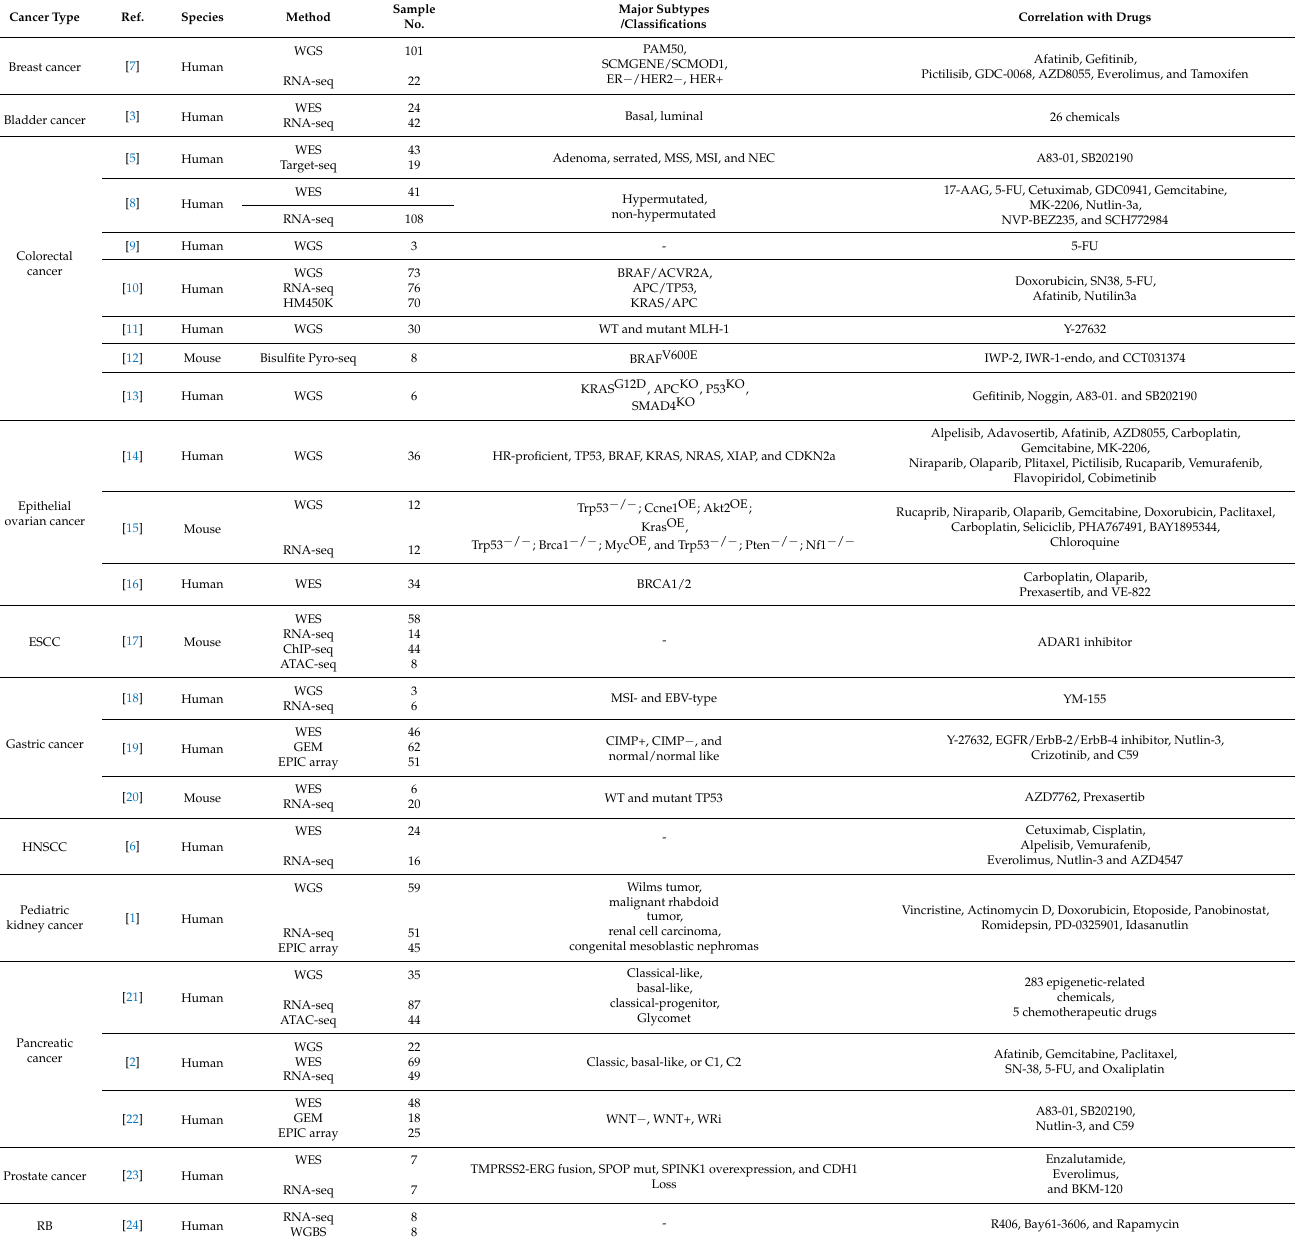
ESCC, esophageal squamous cell carcinoma; GEM, gene expression microarray; HNSCC, head and neck squamous cell carcinomas; No, number; Ref, Reference; RB, retinoblastoma; WT, wild type; WRi, Wnt, and R-spondin- independent; CIMP, CpG island methylator phenotype; WGS, whole-genome sequencing; WES, whole-exome sequencing; WGBS, whole-genome bisulfate sequencing; HM450K, Infinium HumanMethylation450 BeadChip; EPIC array, Infinium MethylationEPIC